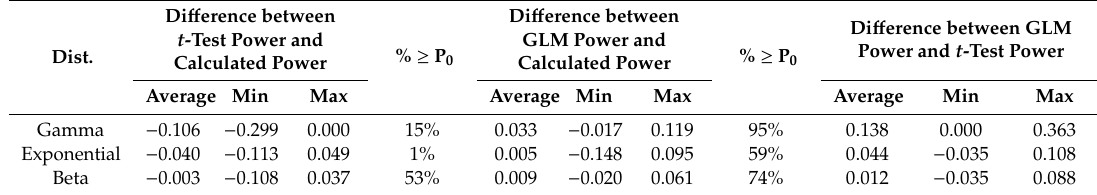
Table 4. Summary of power values for exponential and gamma-distributed data tested using the t -test and GLM: P 0 is the power value of the two-group t -test calculated prior to the simulations, P 1 is the empirical power of the two-group t -test conducted on the log-transformed groups, and P 2 is the empirical power of the GLM-fitted data.